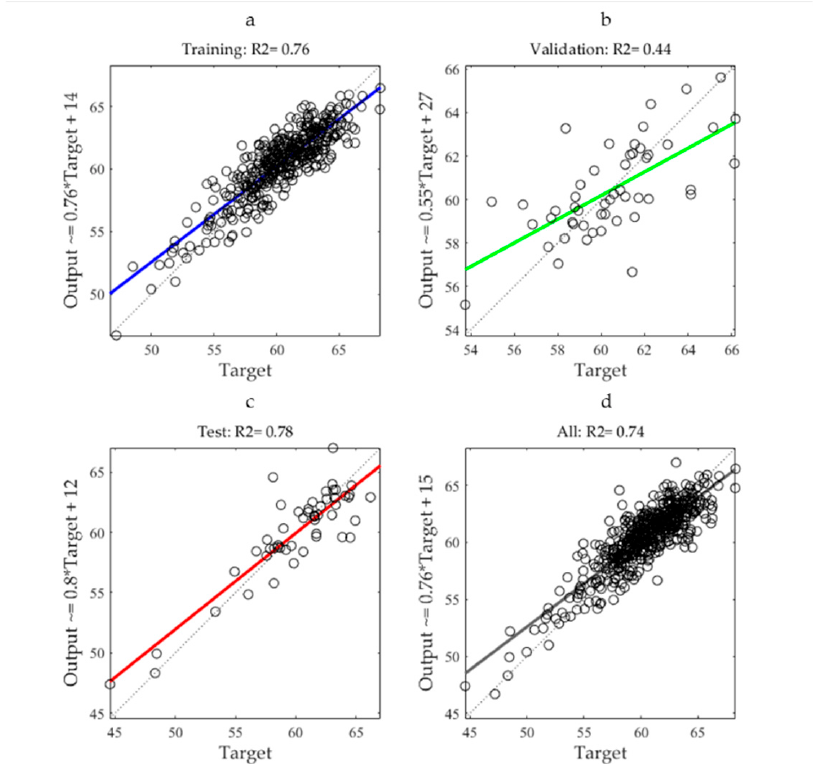
Figure 5. Linear regression between fruit moisture target values and those estimated through ANN model. Each subfigure represents the dataset of training ( a ), validation ( b ), test ( c ), and the whole dataset ( d ).